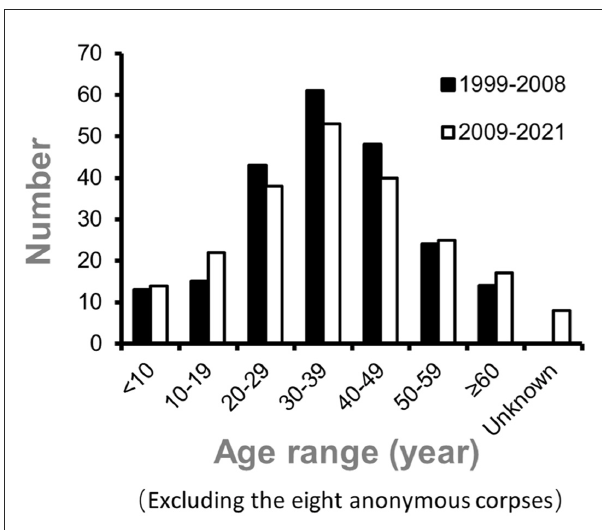
FIGURE1 Age distribution of intoxication deaths between 2009–2021 and 1999–2008 periods at the Tongji Center for Medicolegal Expertise in Hubei, China (4).